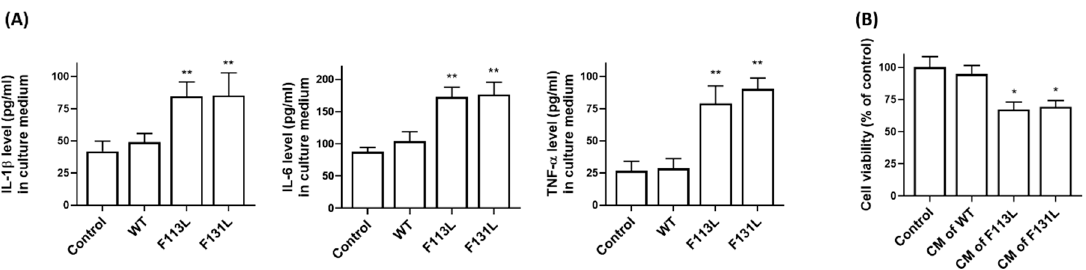
Figure 3. TOMM40 genetic variants induce the secretion of pro-inflammatory cytokines in microglial cells, leading to cell death of hippocampal neurons. ( A ) Compared to control cells or cells expressing WT TOMM40, BV2 microglial cells’ expression of (F113L) or (F131L) TOMM40 significantly increased secretion of pro-inflammatory IL-1 β , IL-6, or TNF- α in culture medium of BV2 microglial cells. ( B ) Culture medium (CM) of HT22 hippocampal neurons was replaced with CM from BV2 microglial cells transfected with cDNA of WT, (F113L) or (F131L) TOMM40. One day after replacement, CM of BV2 microglia cells expressing mutant (F113L) or (F131L) TOMM40 significantly reduced cell viability of HT22 hippocampal neurons. Each bar represents mean ± S.D. of four experiments. Each experiment was performed in triplicate. * p < 0.05 or ** p < 0.01 compared to control BV2 microglial cells or HT22 hippocampal neurons.